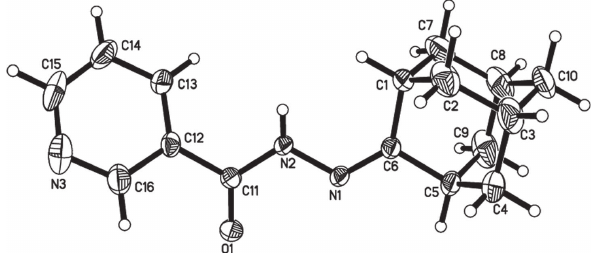
Table 1: Data collection and handling.